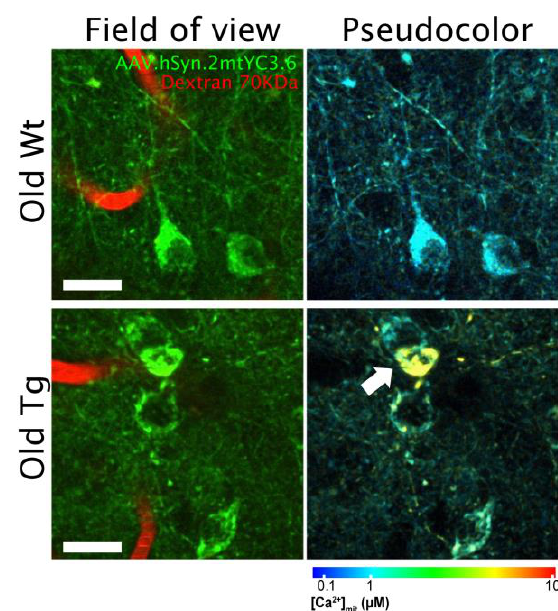
FIGURE 1: In vivo multiphoton microscopy images of mitochon- drial Ca 2+ in neurons in the Wt and APP/PS1 mice. Mice were in- jected with AAV.hSyn.2mtYC3.6 and a cranial window was implant- ed. Mitochondrial Ca 2+ was later evaluated with multiphoton mi- croscopy. Pictures are representative of old wild-type (Wt, top) and transgenic mice (APP/PS1 Tg, bottom). The field of view shows the AAV transduction in neuronal mitochondria (green) and the blood vessels labeled with fluorescent Dextran (red). Pseudocolor images represent the color coded mitochondrial Ca 2+ concentrations for the corresponding field of view images. Arrow points to a neuron with mitochondrial Ca 2+ overload. Scale bar represents 20